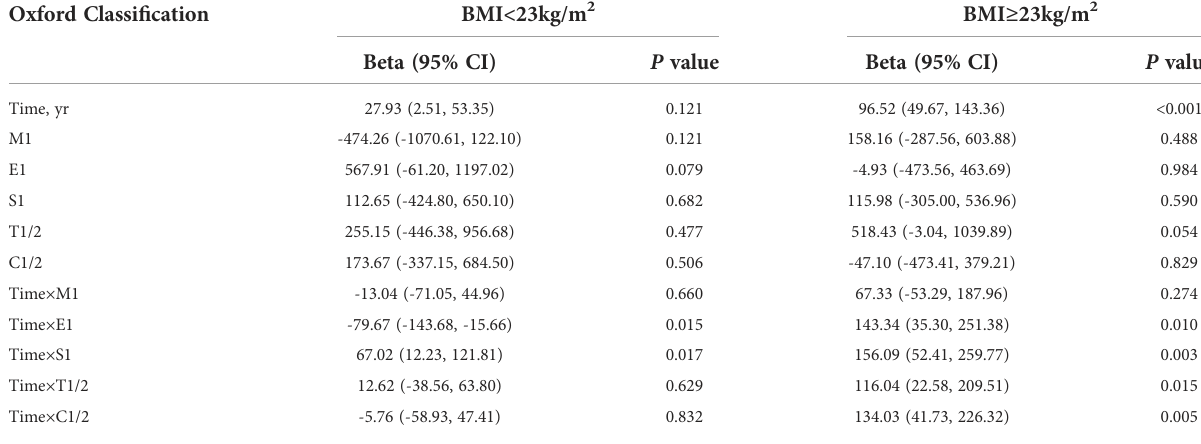
TABLE 4 Association of the Oxford Classi fi cation score MEST-C with the changes in PCR according to BMI < 23kg/m 2 and BMI ≥ 23kg/m 2